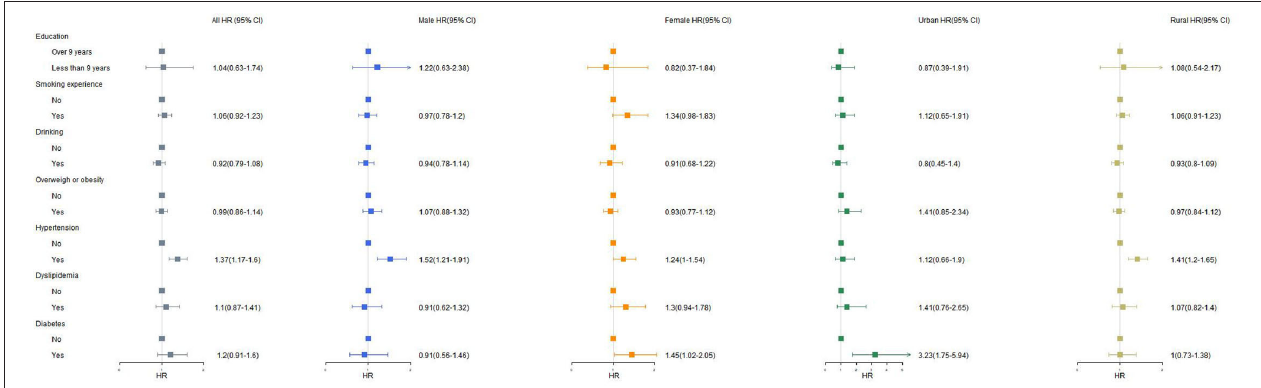
FIGURE 4 | The association with health-related factors and multimorbidity. Over 9 years of education: 2-/3-year college/associated degree, 4-year-college/bachelor’s degree, master’s degree and doctoral degree/Ph.D. Overweight or obesity defined as their body mass index (BMI) being over 24.0 (kg/m 2 ). Having hypertension, dyslipidemia or diabetes defined as having been diagnosed by doctor. HR, hazard risk; CI, confidence